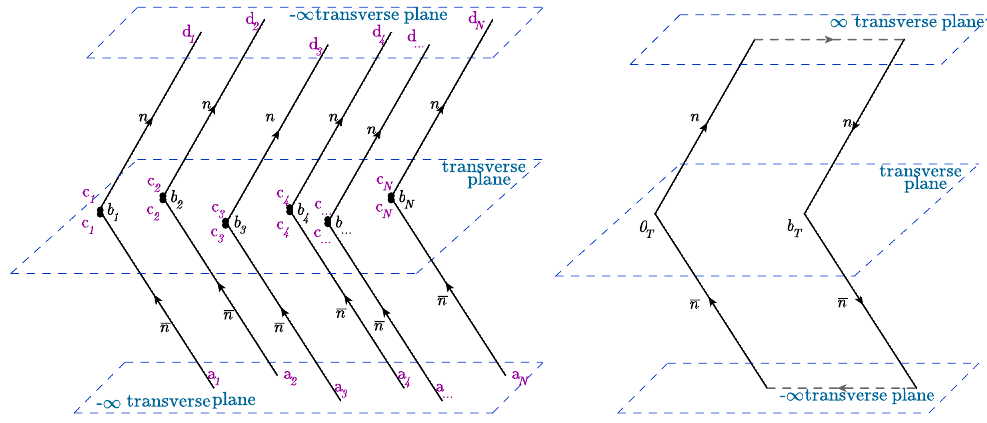
Figure 1 . Visualization of the expression for the MPS soft factor (3.2) (left) and the TMD soft factor (right). The lines with arrows represent the Wilson lines with the color-(cid:13)ow in the direction of the arrow. The purple letters show the color indices, the black letters show the transverse positions and